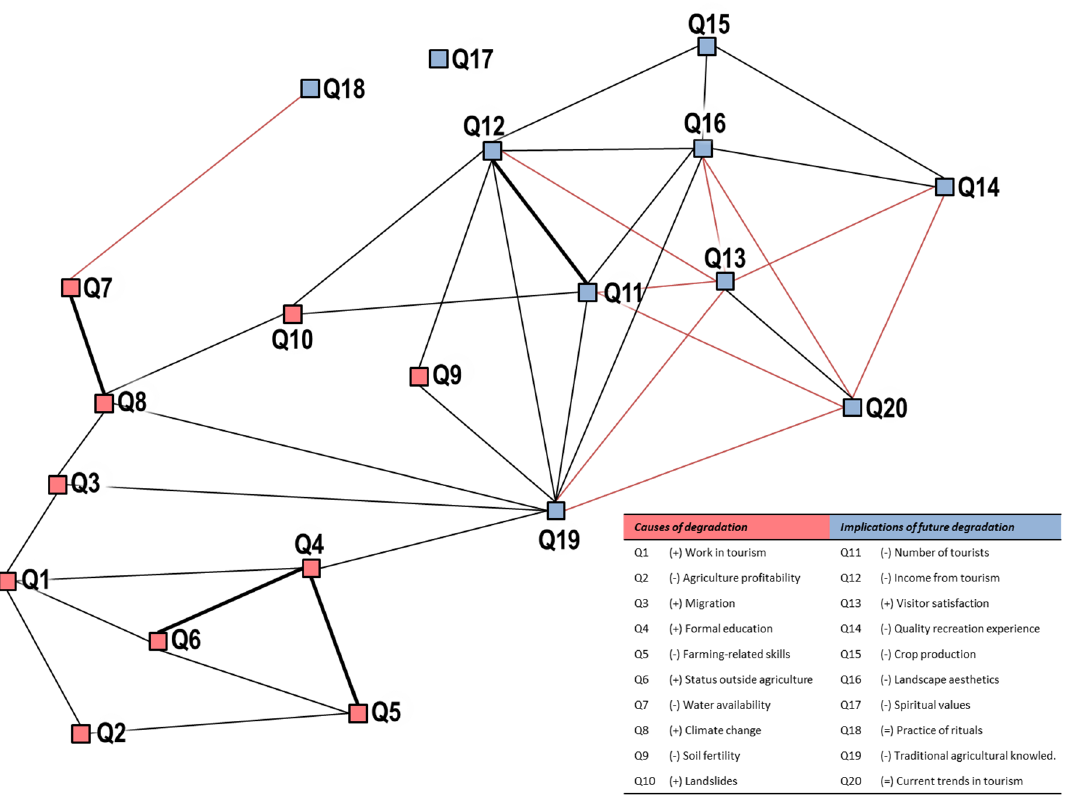
Figure 4. Network of highly significant correlations between the answers to the survey. Statement listed in Table 1. Only highly significant correlations are represented; bold lines represent coefficients >0.5; red lines represent negative coefficients. Red nodes represent causes of landscape degradation and blue nodes represent implications of landscape degradation. Source: Own